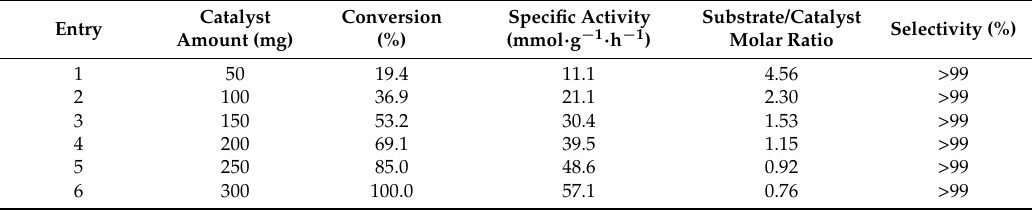
Table 5. Effect of the catalyst ZnO x (1%)–MnCO 3 /(1%)HRG amount on the catalytic performance.